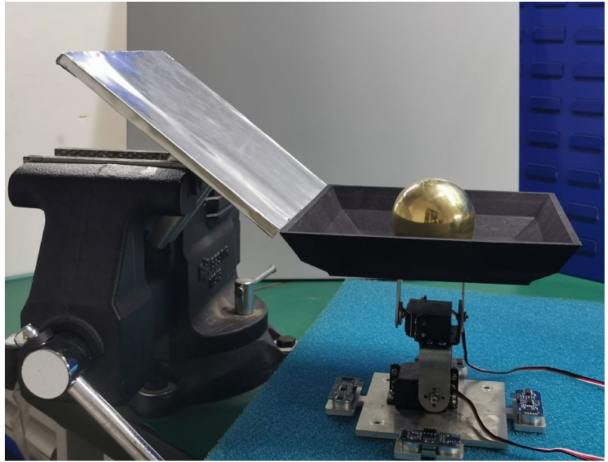
Figure 18. A representation of the experimental sorting mechanism. It comprises the slideway, the two-DoF parallel platform, and the surveillance